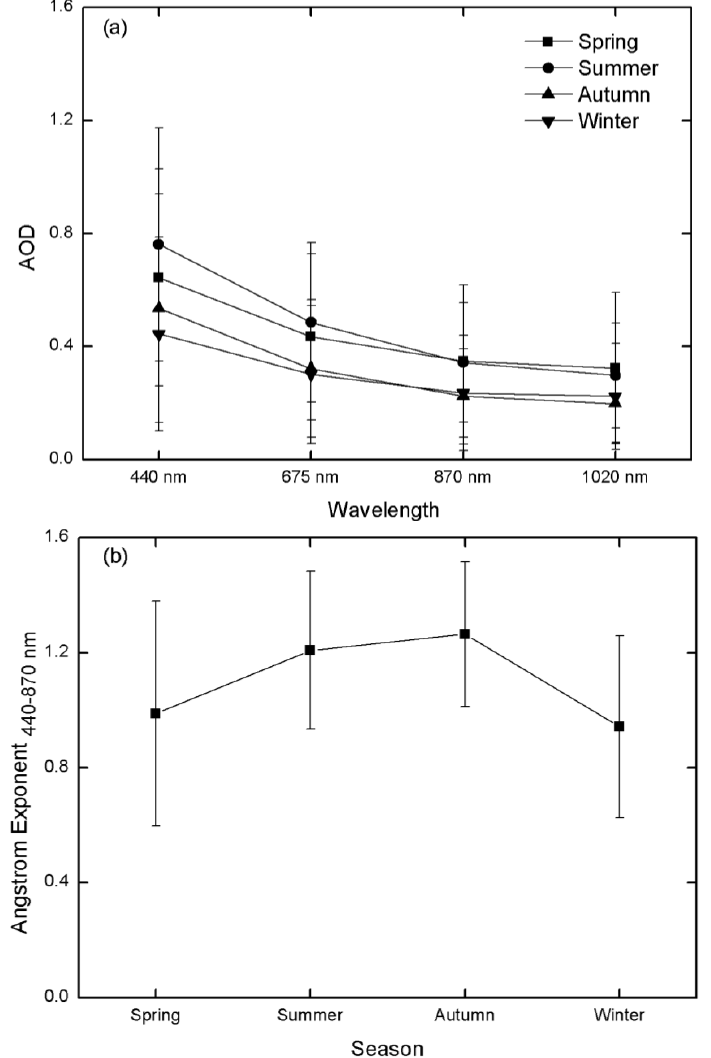
Figure 4. Seasonal variations with mean ± SD in the ( a ) AOD and ( b ) Ångström exponent at Dalian monitoring station.